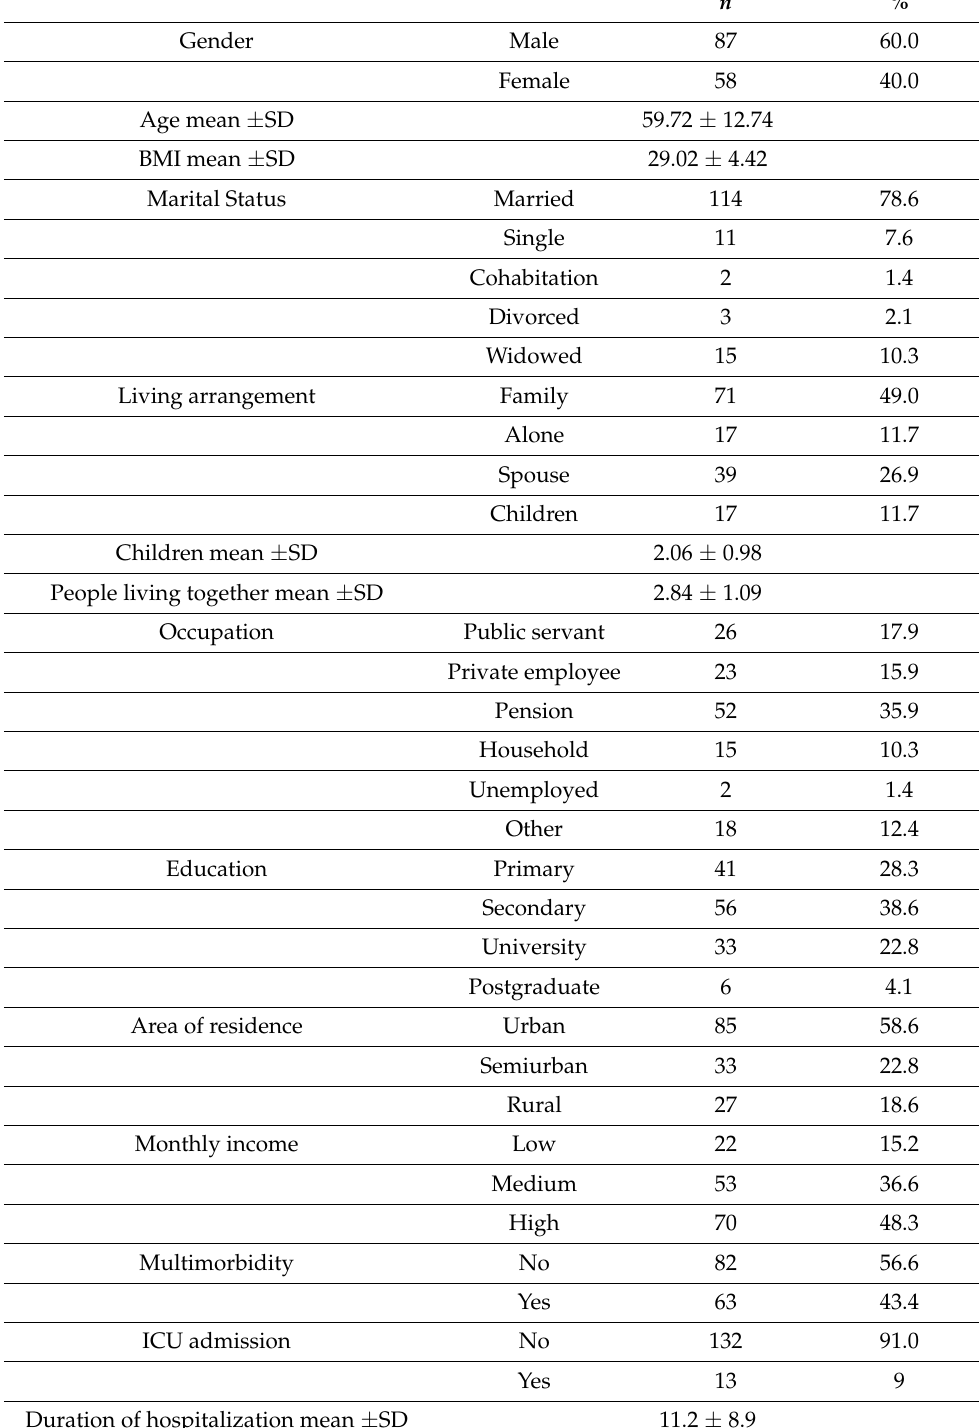
Table 1. Sociodemographic and clinical